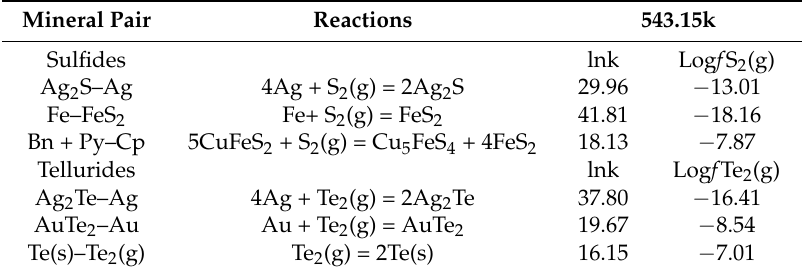
Table 3. Equilibrium constant (lnK) and gaseous substance fugacity (log f ) of the reactions in each mineral pair at 543.15k (Univariate system).